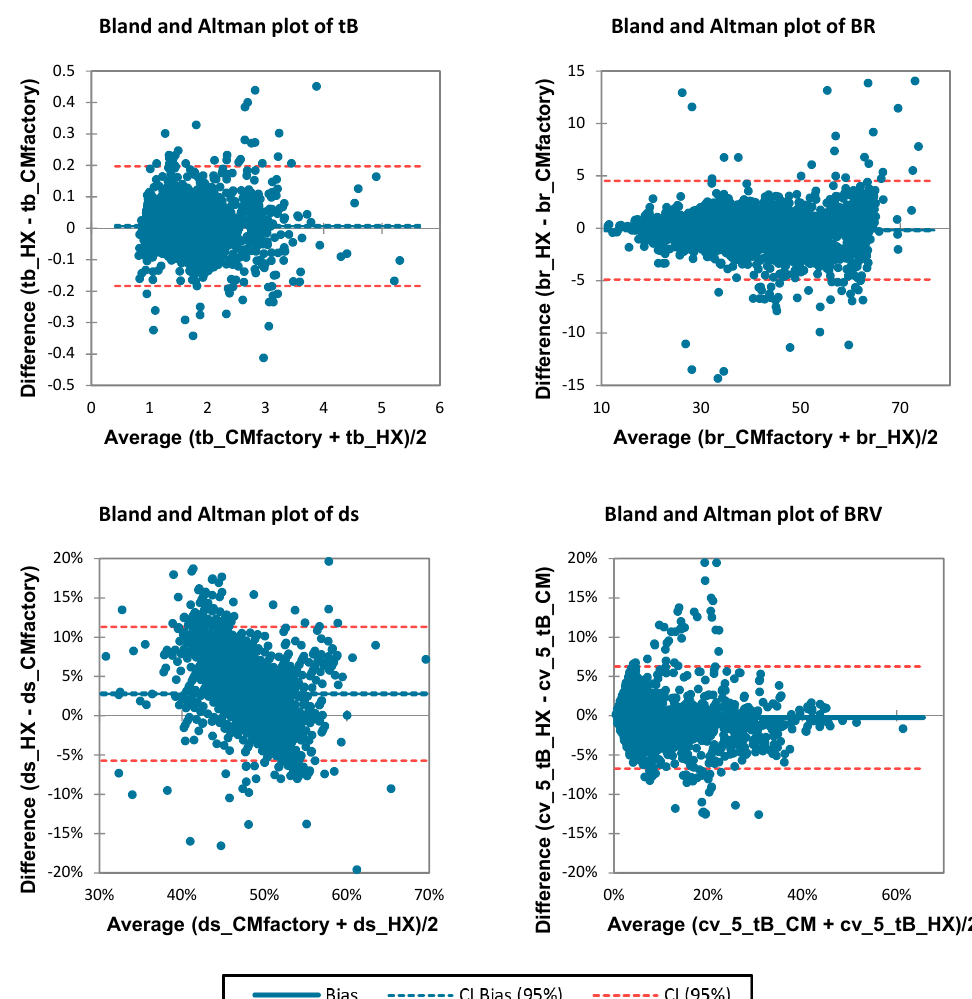
Figure 7. Bland–Altman plots of all BP comparisons. CI: 95% confidence interval.